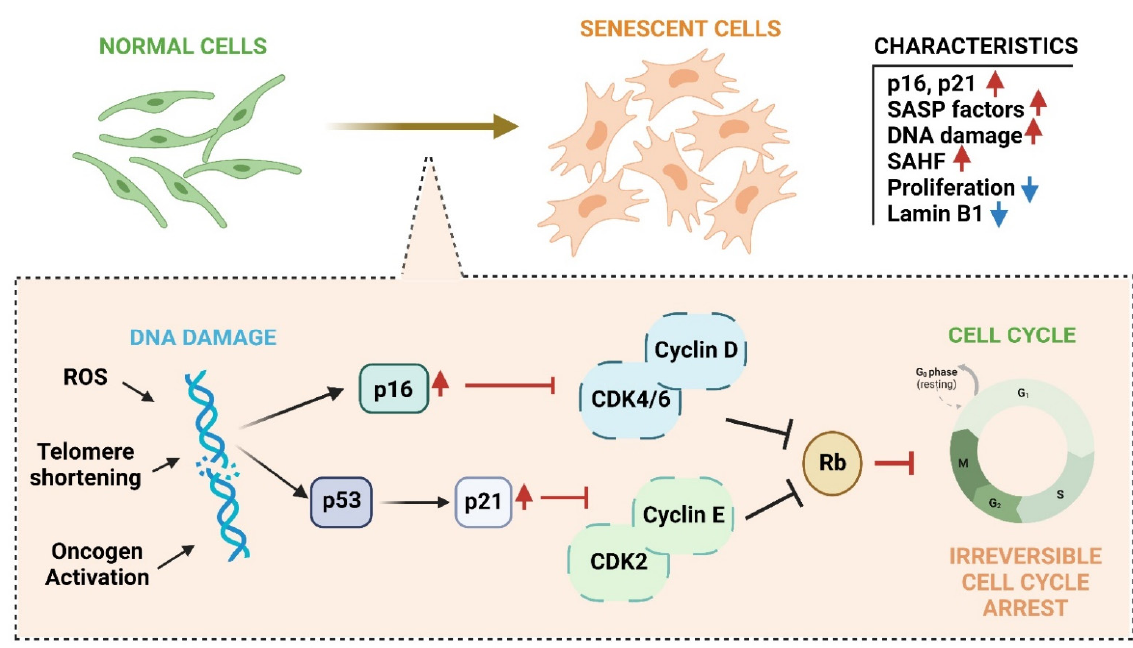
Figure 4. Cell cycle arrest pathways that are activated during senescence. Various stressors, such as irradiation, telomere shortening, oncogene activation, and increased ROS, generate DNA damage that induces DDR and activates the p53-p21 and p16 pathways, which inhibit specific cyclin-dependent proteins. Rb inhibitory kinase prevents cycle progression by inhibiting EF2 (not shown in the image), which leads to irreversible cell cycle arrest in senescent cells. In addition, senescent cells present other characteristics such as decreased nuclear protein Lamin B1, senescence-associated heterochromatin foci (SAHF) formation, increased DNA damage, and increased SASPs. During aging, the increase in damage by ROS makes these protective mechanisms fundamental and triggers a progressive cellular senescence activation [117].